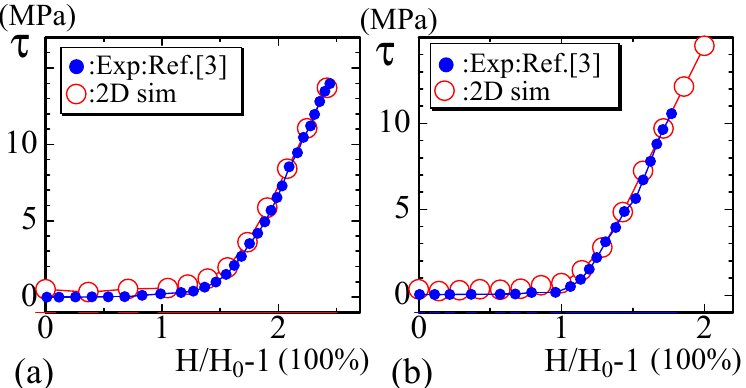
Figure 6. Experimental data τ exp (Exp) and the simulation data τ sim (sim) for snake skin with a toe region of ( a ) 125% and ( b ) 100% in units of strain [5]. These experimental data are examples of diagrams with an S-heel, and the 2D simulation results are used for comparison with these experimental data.